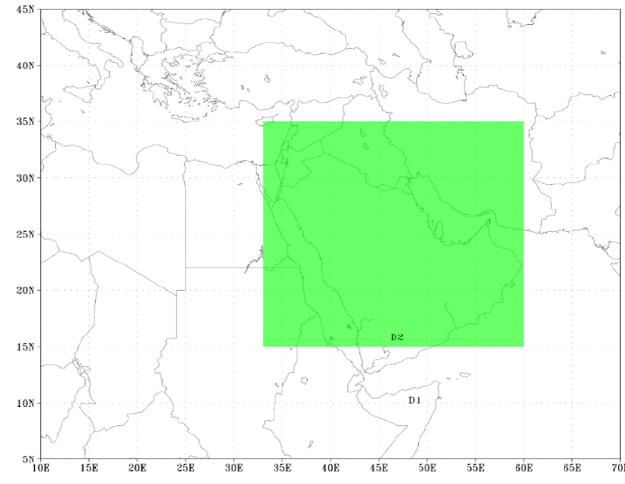
Figure 5. Successive nested domains for model